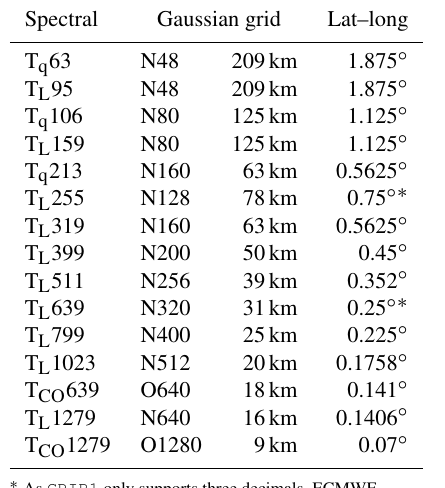
Table 4. Approximate correspondences between spectral, Gaussian and latitude–longitude grid resolutions. Source: ECMWF (2017, 2019d,e), Berrisford et al. (2011), Laloyaux et al. (2016). For the spectral grid the truncation number is denoted by “T” where the subscript “q” means quadratic grid and “l” means linear grid. The quadratic grid cannot be selected with flex_extract. The correspond- ing reduced Gaussian grids are denoted by “N” followed by the number of lines between the pole and the Equator. The new octahe- dral grid is denoted by “T CO ”, meaning “spectral cubic octahedral”; they correspond to a octahedral reduced Gaussian grid, denotes with an “O”.